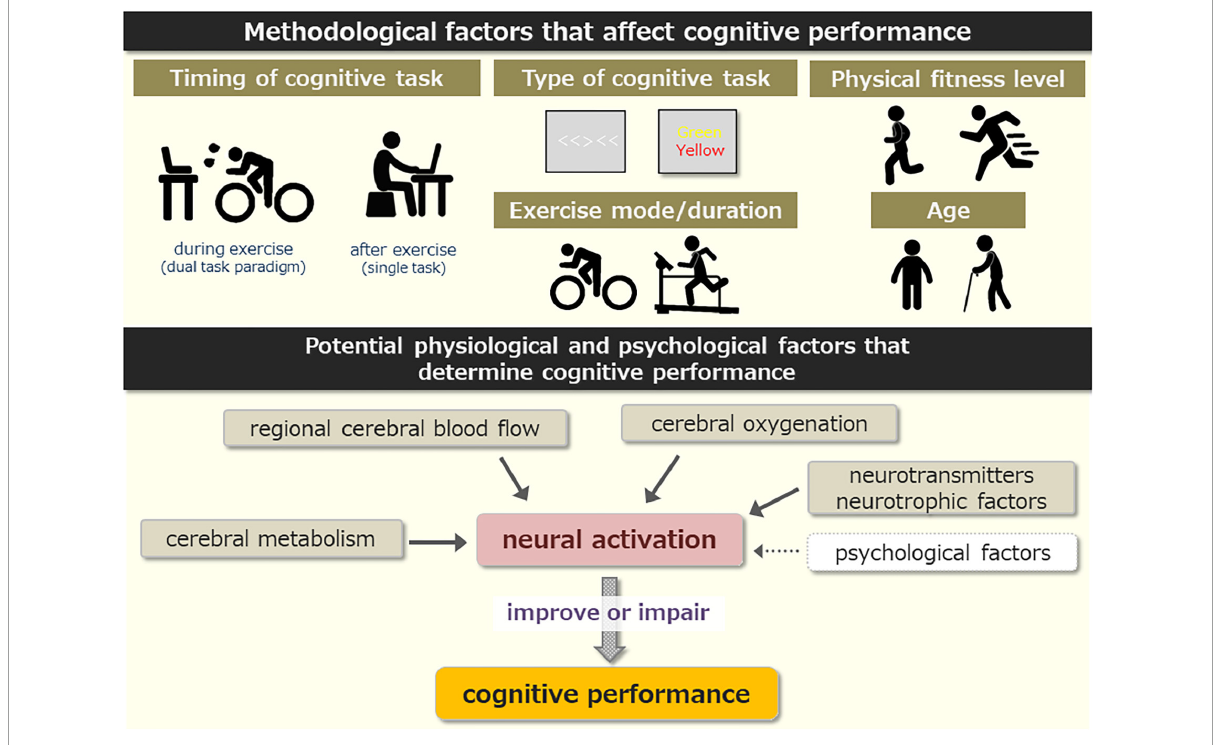
FIGURE1 (Upper) Summary of methodological factors that affect cognitive performance in response to high-intensity exercise. (Lower) Potential physiological and psychological factors that mediate cognitive